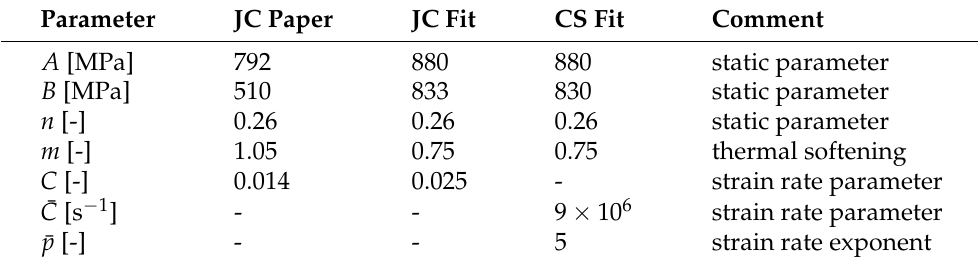
Table 1. Estimated JC and CS parameters: static behaviour determined according to test data [21] and dynamic behaviour, according to Lee and Yeh [39]. The values are converted from the test strain rate to the reference strain rate of 1 s − 1 .